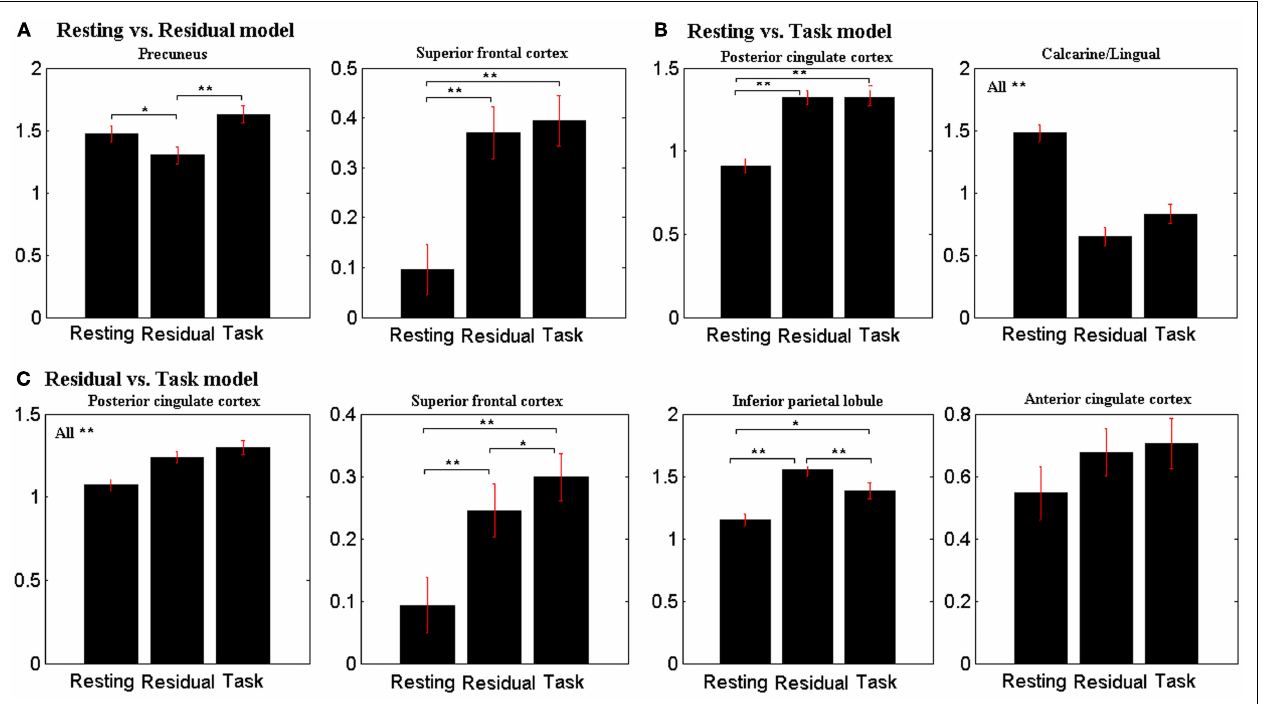
FIGURE 3 | Fractional amplitude of low-frequency fluctuation (fALFF) of observed ROIs (Table 2) during resting, task-residual, and task for (A) resting vs. residual model, (B) resting vs. task model, and (C) residual vs. task model. Vertical bars represent standard error of the mean. ** p < 0.001, * p <